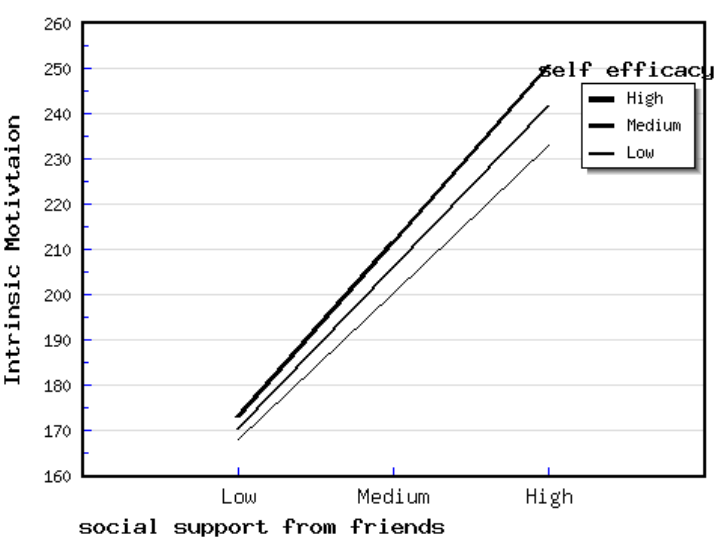
Figure 1: Showing the effect of social support from friends on intrinsic motivation as moderated by